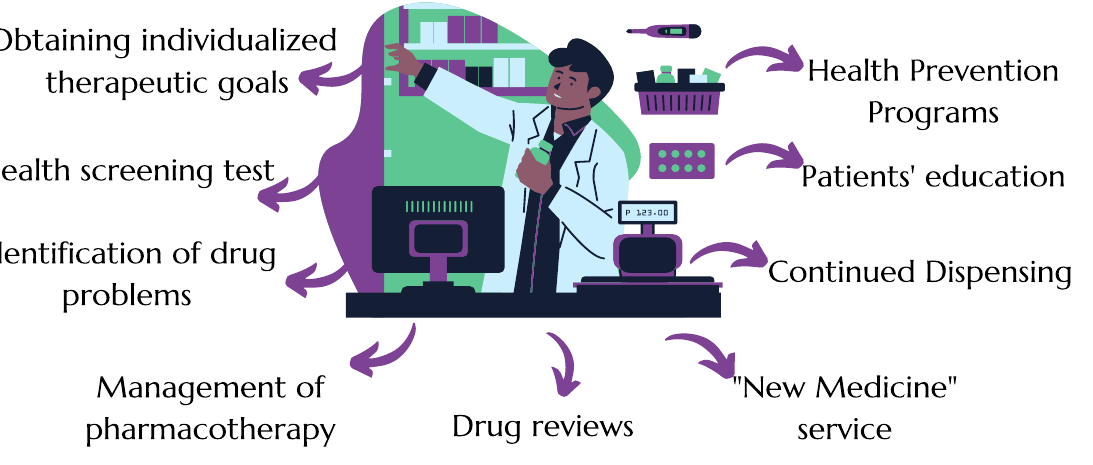
Figure 1. Proposed pharmaceutical services [5].